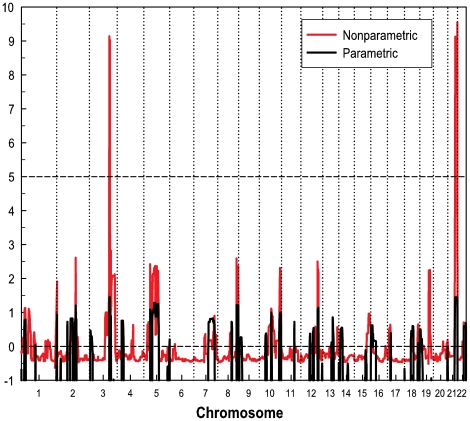
Genome-wide parametric and nonparametric linkage results of the FH pedigree.In the parametric linkage analysis, an autosomal dominant model with a risk allele penetrance of 0.2 and a phenocopy rate of 0.0001 was assumed.